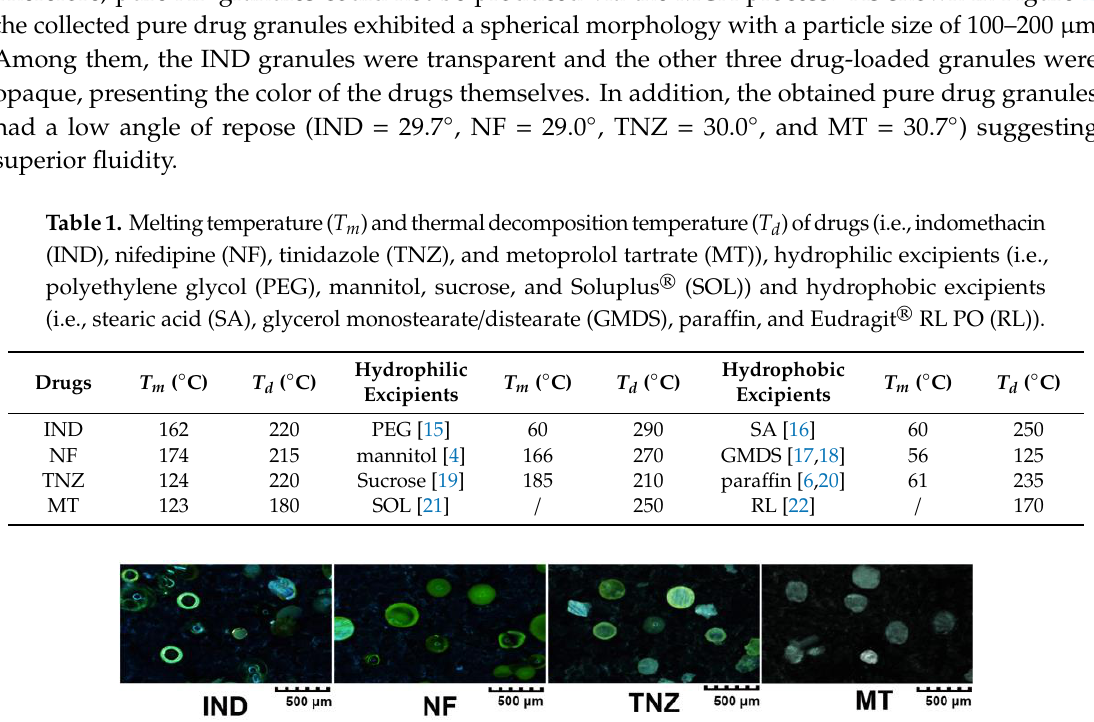
Figure 2. Morphology of indomethacin (IND), nifedipine (NF), tinidazole (TNZ), and metoprolol tartrate (MT) granules observed using a stereomicroscope.